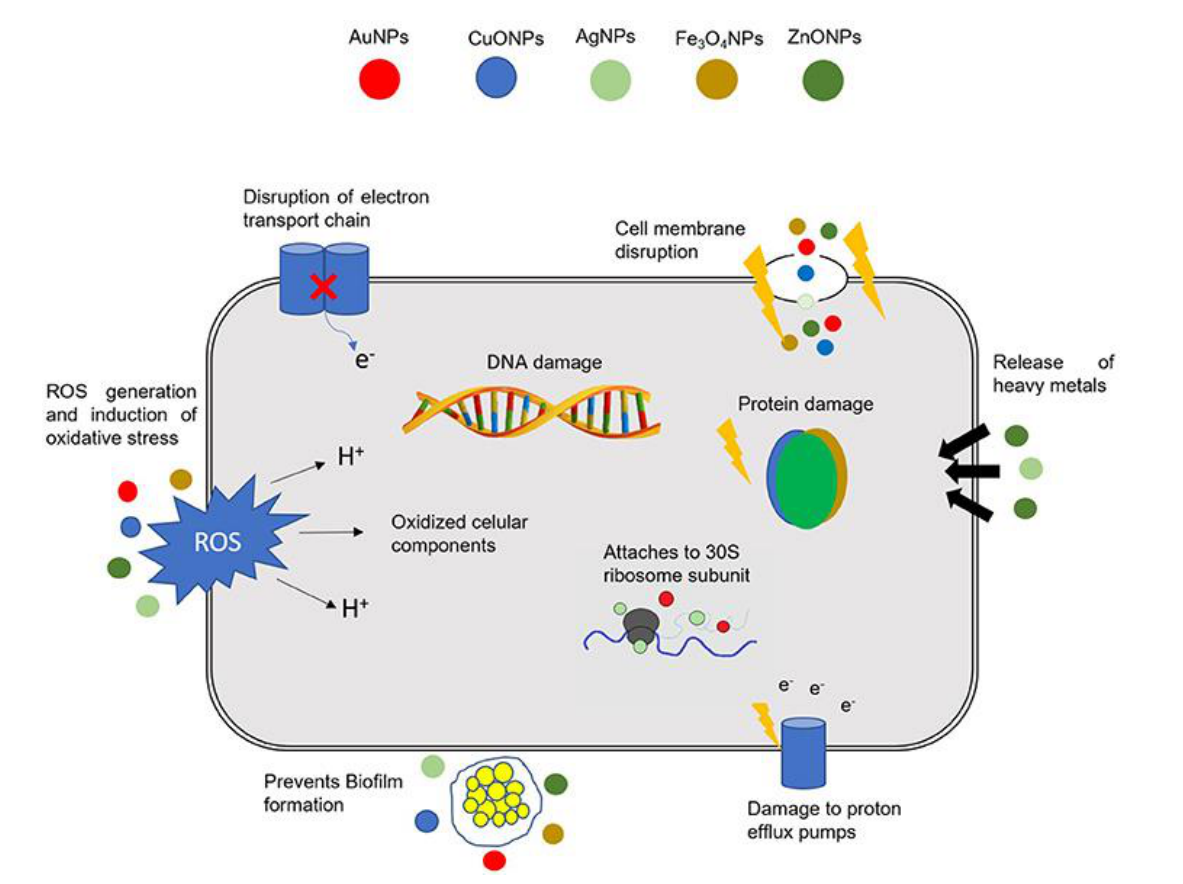
Figure 5. Different mechanisms of action of MNPs in microbial cells. The combination in a single nanomaterial of a multitude of cellular effects may have a tremendous impact in fighting multi-drug- resistant microorganisms (From [129] with permission from Frontiers in Microbiology).